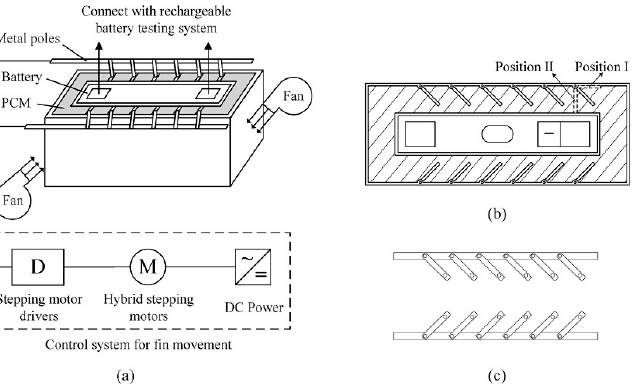
Figure 14. The dual active-passive BTMS system [56]. ( a ) Components and connections; ( b ) Container with the battery; ( c ) Aluminum poles used to drive the fins. Reproduced with permission from Elsevier.